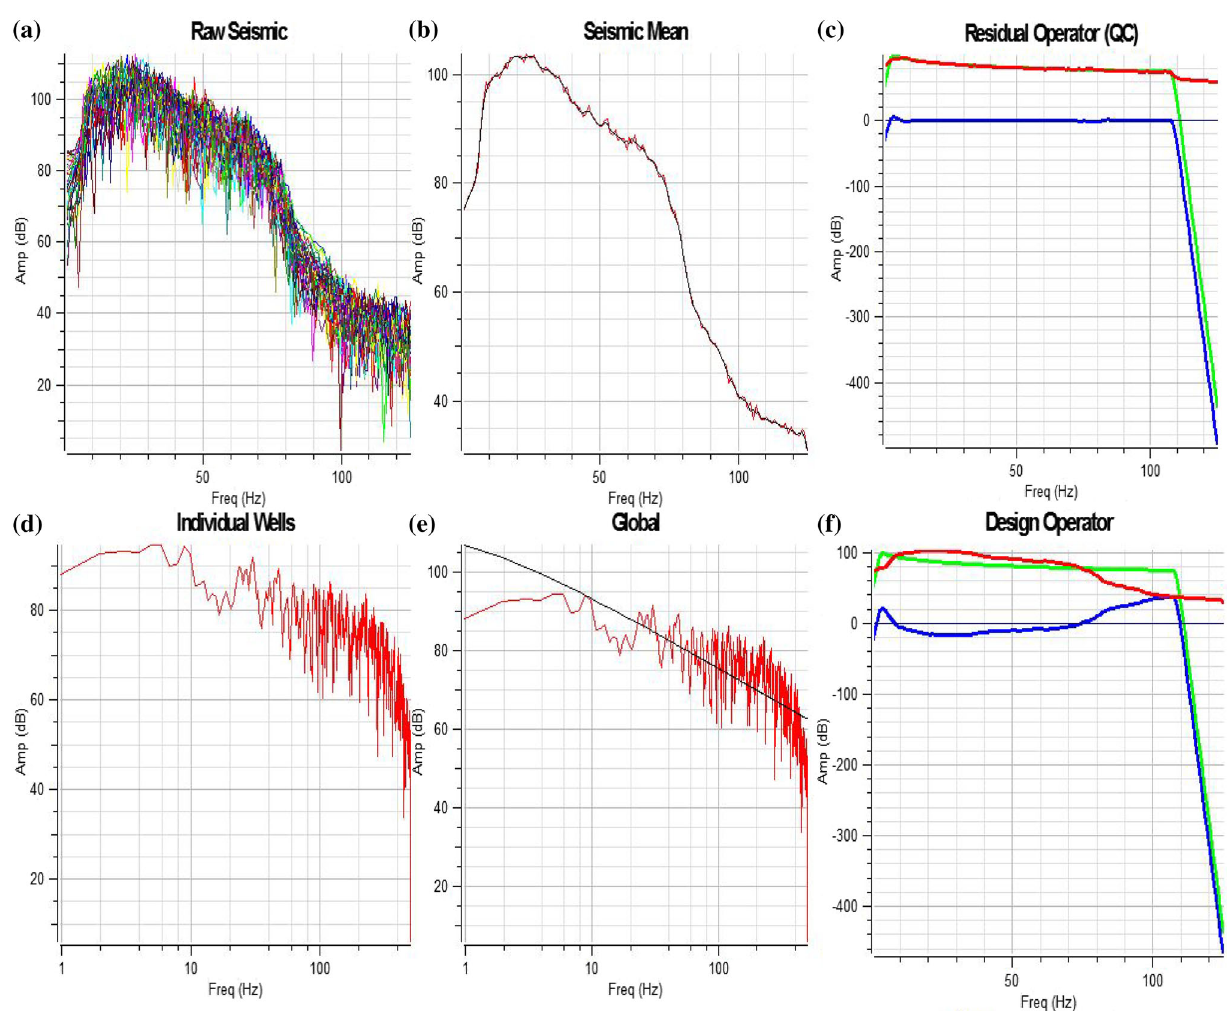
Fig. 15 Parameters used for generating seismic coloured inversion (SCI) ( a ) Raw seismic spectra, b smoothed version of the computed seismic mean amplitude spectra, c residual operator, d extracted wells impedance spectra, e global, this represents the computed mean of the